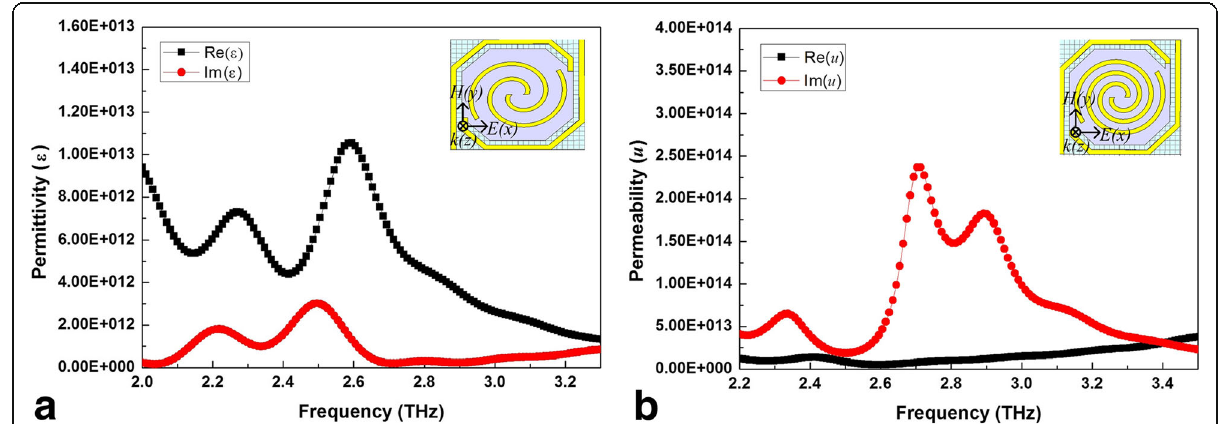
Fig. 7 Real and imaginary parts of effective permeability ( a ) and permittivity ( b ) as a function of frequency for micro-bridge structure coupled with spiral-type antenna with two separate linear antennas when n = 1.6 and i = −